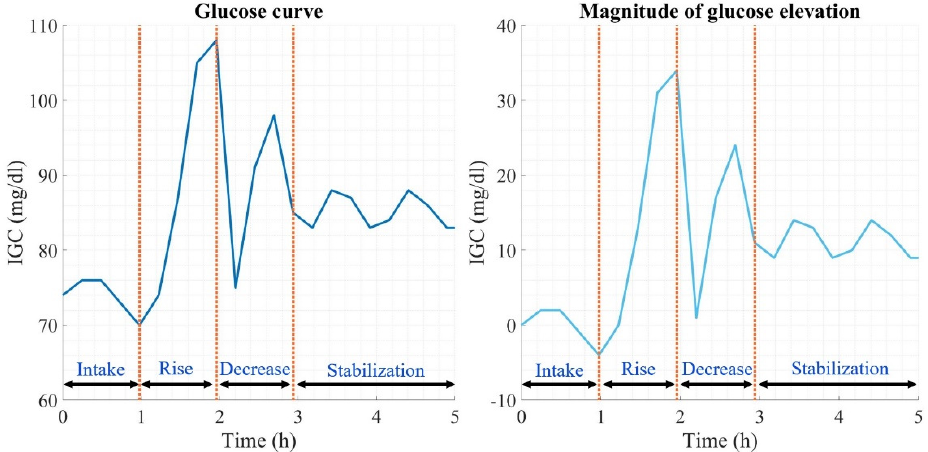
Figure 1. Glucose curve description.